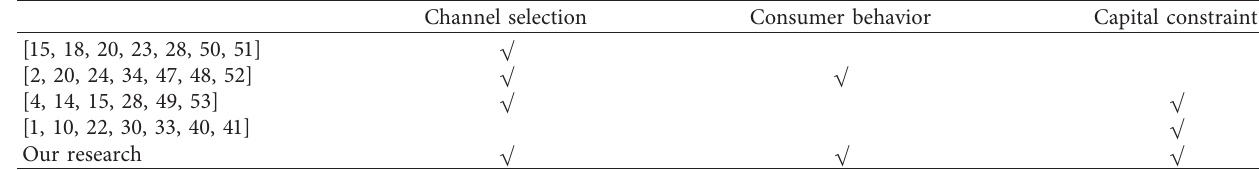
Table 1: The gap between existing literature and our research.